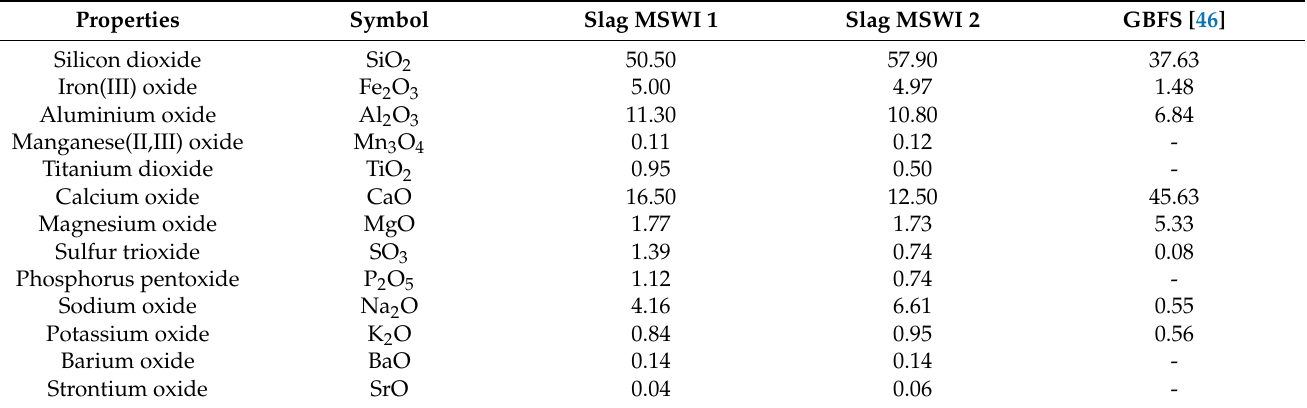
Table 4. Content of oxides (%) in the tested materials.